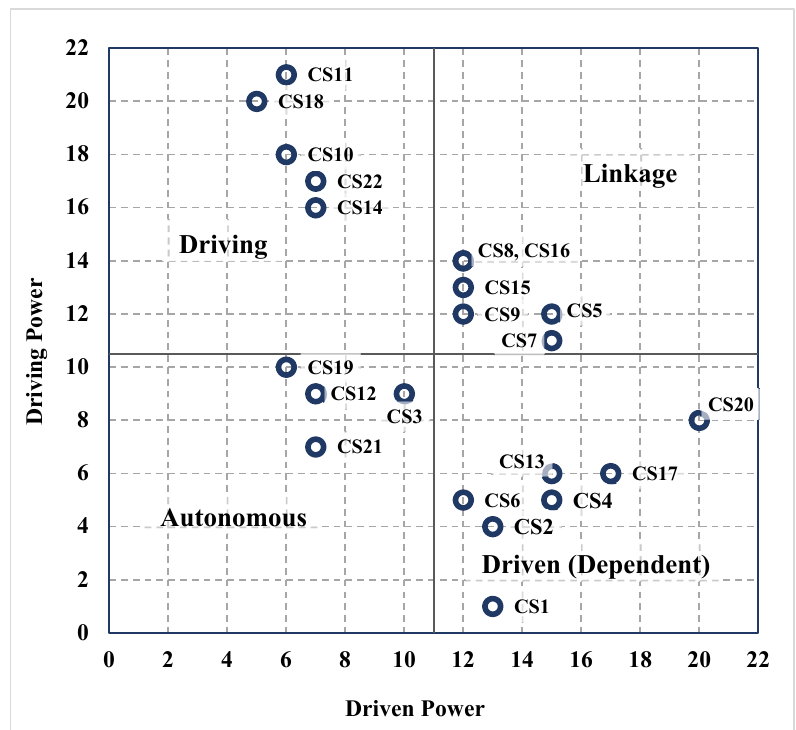
Figure 3. Constraints’ driving and driven (dependence) powers. Table 6. The effect levels.